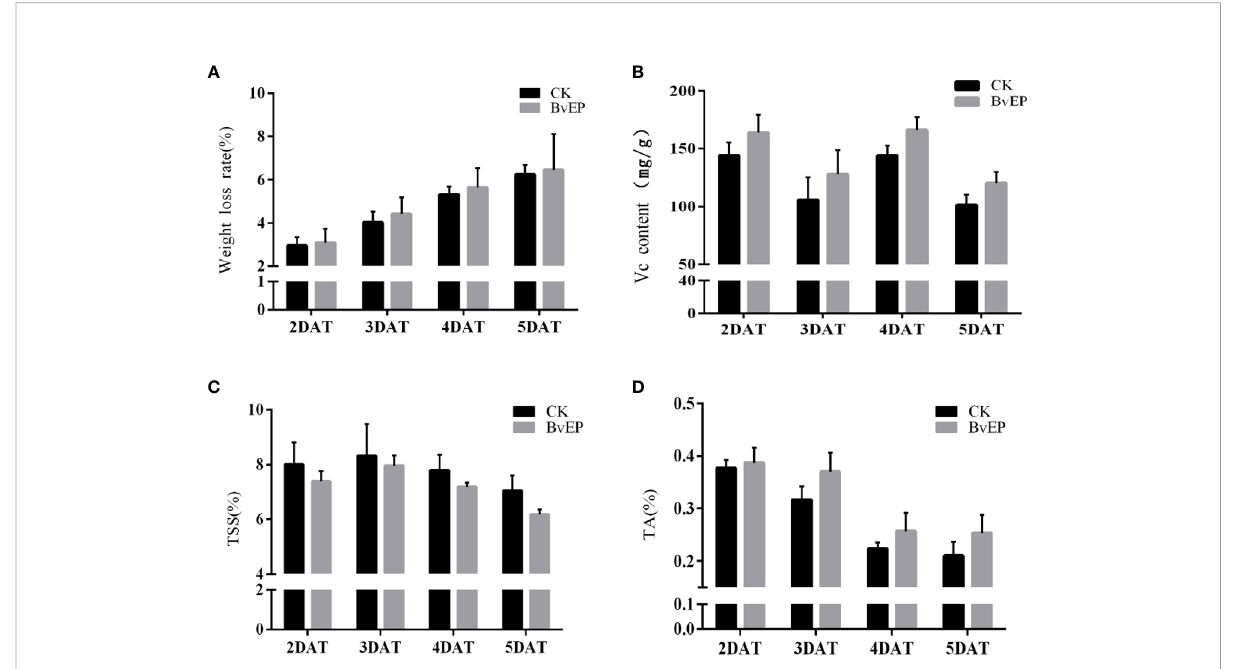
FIGURE 7 Effect of BvEP on physiological indicators of tomato fruits during storage. (A) Weight loss of tomato fruits at 2 DAT, 3 DAT, 4 DAT, and 5 DAT with pK7LIC4.0 and pK7LIC4.0-BvEP; (B – D) are separately Vc, TSS, TA content in tomato fruits at 2 DAT, 3 DAT, 4 DAT, and 5 DAT with pK7LIC4.0 and